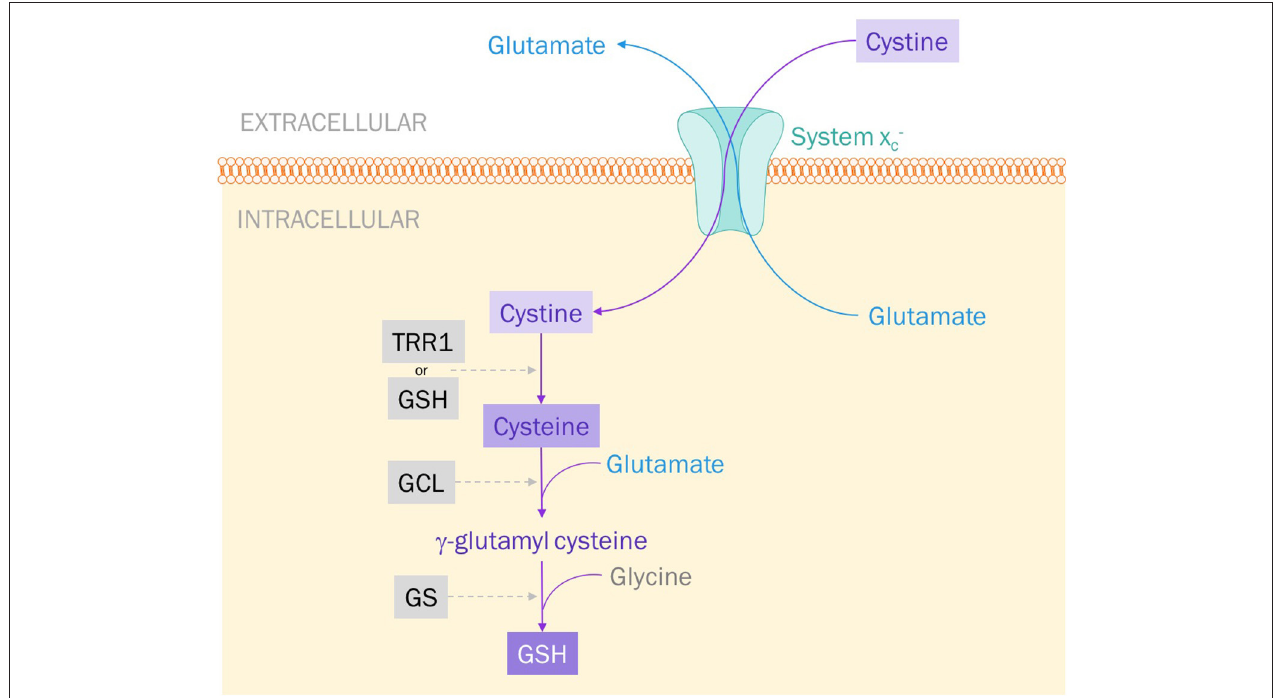
FIGURE 1 | System x − c exports glutamate and imports cystine. Cystine is reduced to cysteine by either thioredoxin reductase 1 (TRR1) or glutathione (GSH). Glutamate cysteine ligase (GCL) catalyzes the addition of glutamate to cysteine to produce γ -glutamyl cysteine. Glutathione synthase (GS) catalyzes the final step: the addition of glycine to produce